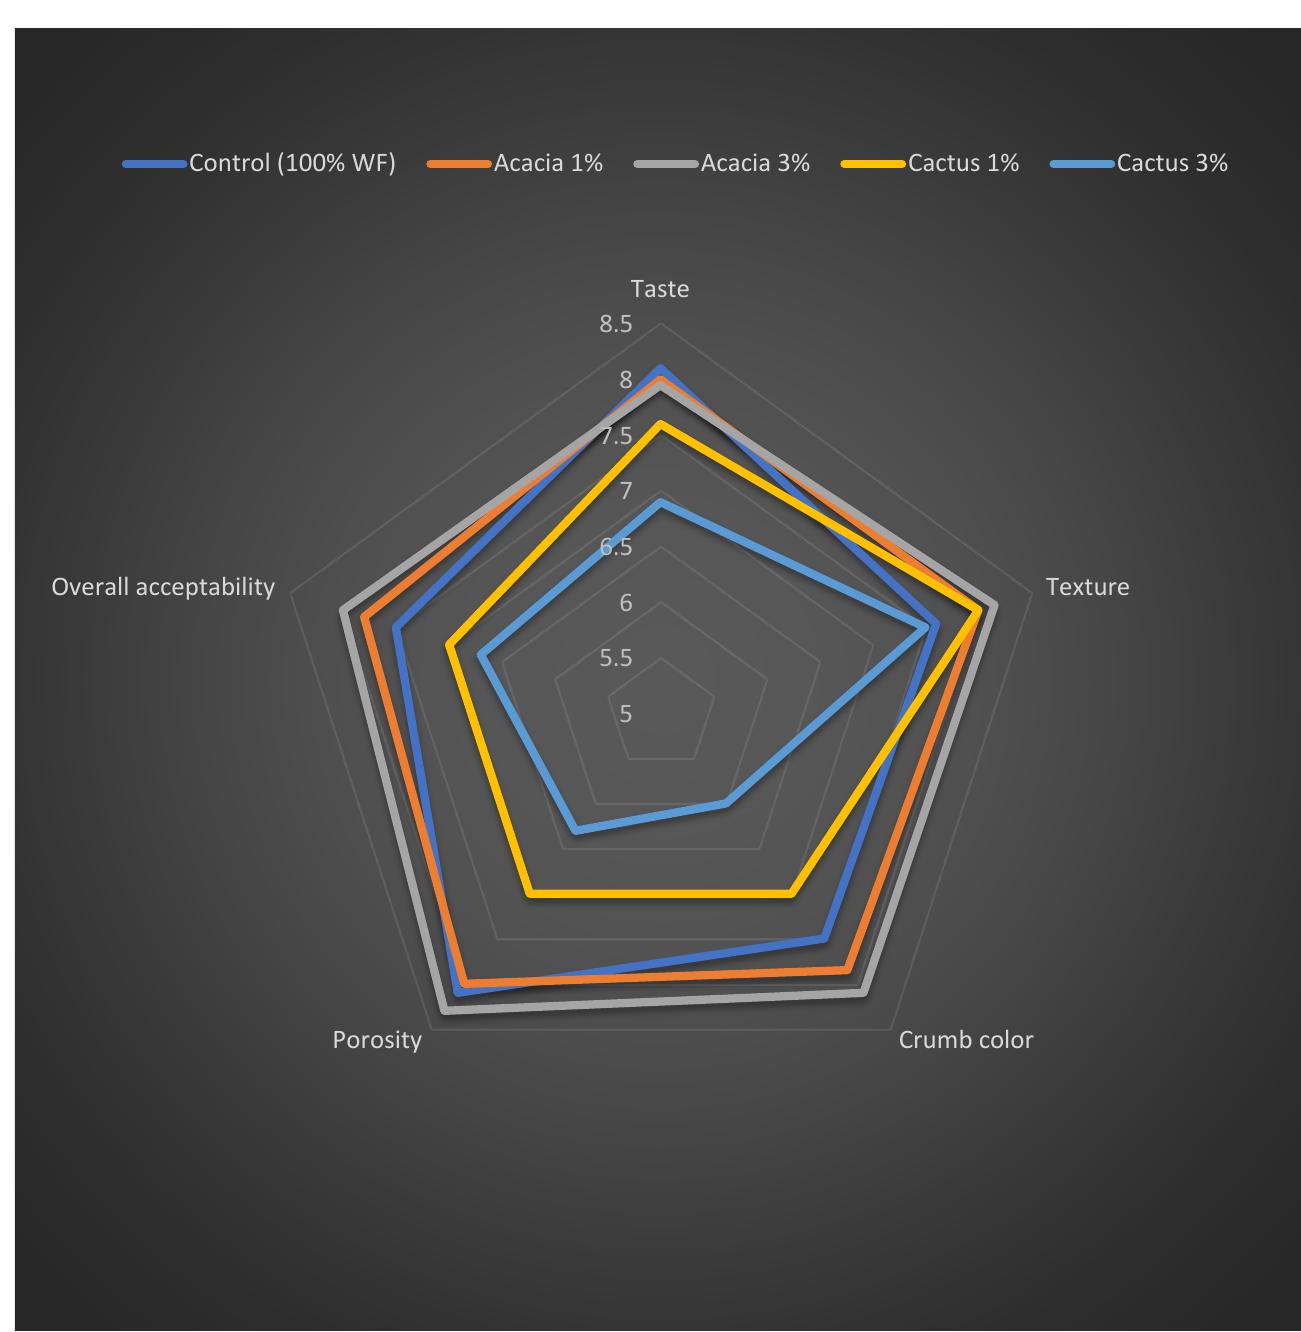
Figure 5. Sensory scores for cakes containing acacia and cactus gums. Porosity is a critical feature in determining the sponge cake’s sponginess and fluffy texture. The addition of 3% acacia gum resulted in a crumb that was even more porous than the control, hence, this remained the best sample. Figure 4 depicts the cake’s uniform but homogeneous porous crumb cells, which contain 3% more acacia than the other samples. In comparison with the control and the other gum-containing samples, the inclusion of cactus gum resulted in the relatively larger non-homogenous pores of the crumb, which could have resulted in the lowest hedonic scores and the lowest level of acceptance. Thus, the cake’s overall acceptability remained higher when acacia gum was added in comparison with the control, as well as when cactus gum was added. The inclusion of xanthan gum decreased the sponge’s overall acceptability